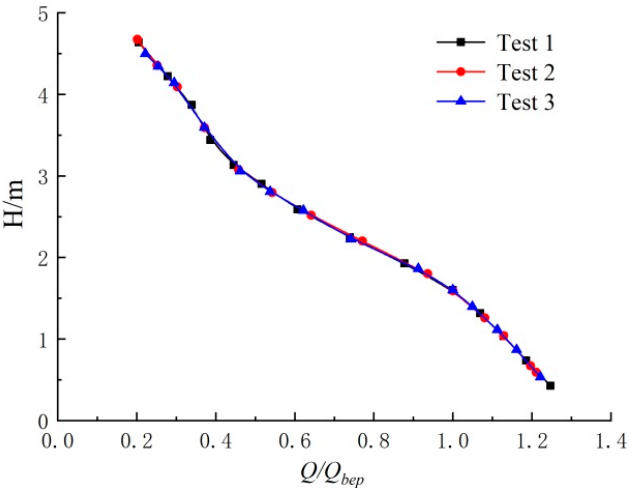
Figure 8. Energy performance repeatability test of axial-flow pump device.